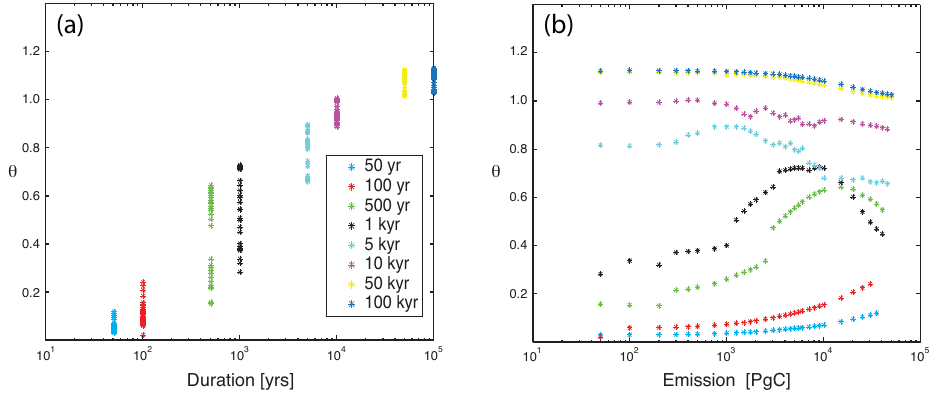
Figure 12. Ratio of the rate of change in total global dissolved inorganic carbon to the rate of change in global total alkalinity (a) vs. duration, at the time of maximum p CO 2 , and (b) vs. emission, at the time of maximum p CO 2 .